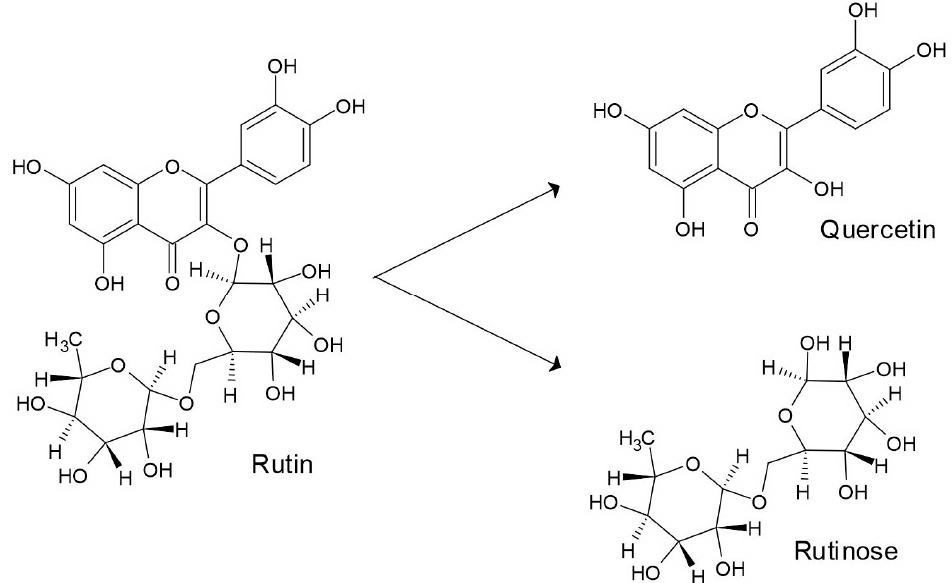
Figure 3. Transformation of rutin to quercetin and sugar rutinose.